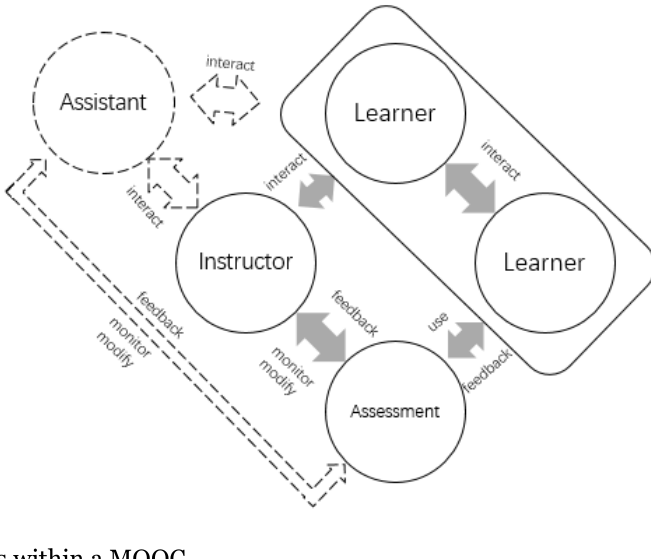
Figure 2. Interactions within a